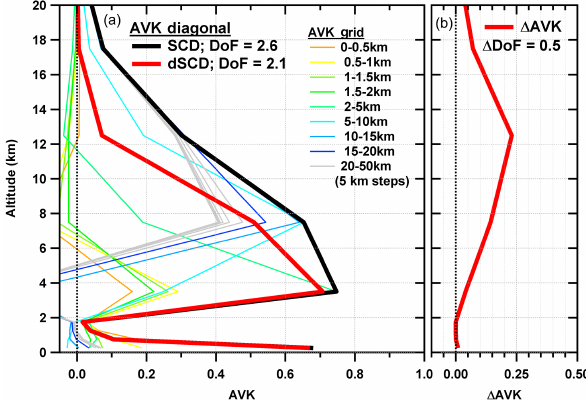
Figure 4. Characterizing the retrieval averaging kernel (AVK) and degrees of freedom (DoF). (a) AVK output for an inversion of BrO SCDs (at SZA = 25 ◦ ) as a function of altitude. The colored traces represent the individual altitude grids of the inversion accounting for SCD Ref ; the thick black trace is the diagonal of the AVK ma- trix; the thick red trace is the diagonal of the AVK matrix from the inversion not accounting for SCD Ref . Panel (b) shows the difference between the two AVK diagonals as a function of